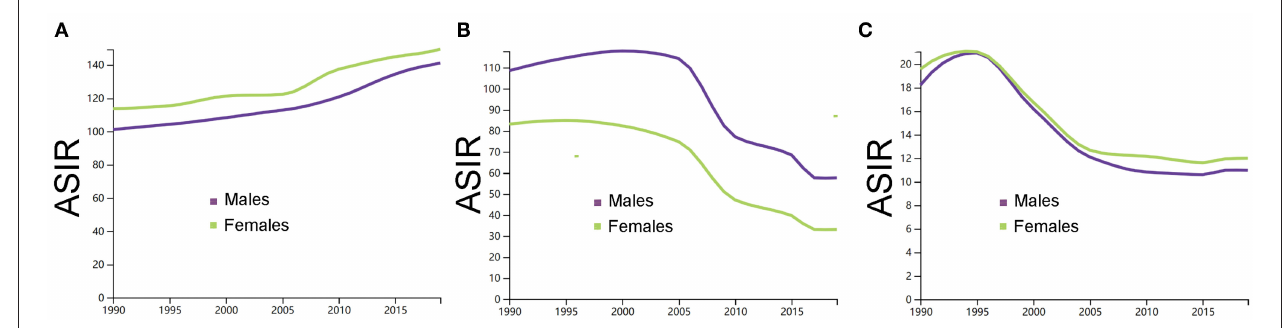
FIGURE 2 | (A) Comparison of men and women in the age-standardized incidence rate per 100,000 of ischemic stroke. (B) Comparison of men and women in the age-standardized incidence rate per 100,000 of intracerebral hemorrhage. (C) Comparison of men and women in the age-standardized incidence rate per 100,000 of subarachnoid hemorrhage. ASIR, age-standardized incidence rate; ICH, intracerebral hemorrhage; and SAH, subarachnoid hemorrhage. The figures were generated through GBD Results Tool.